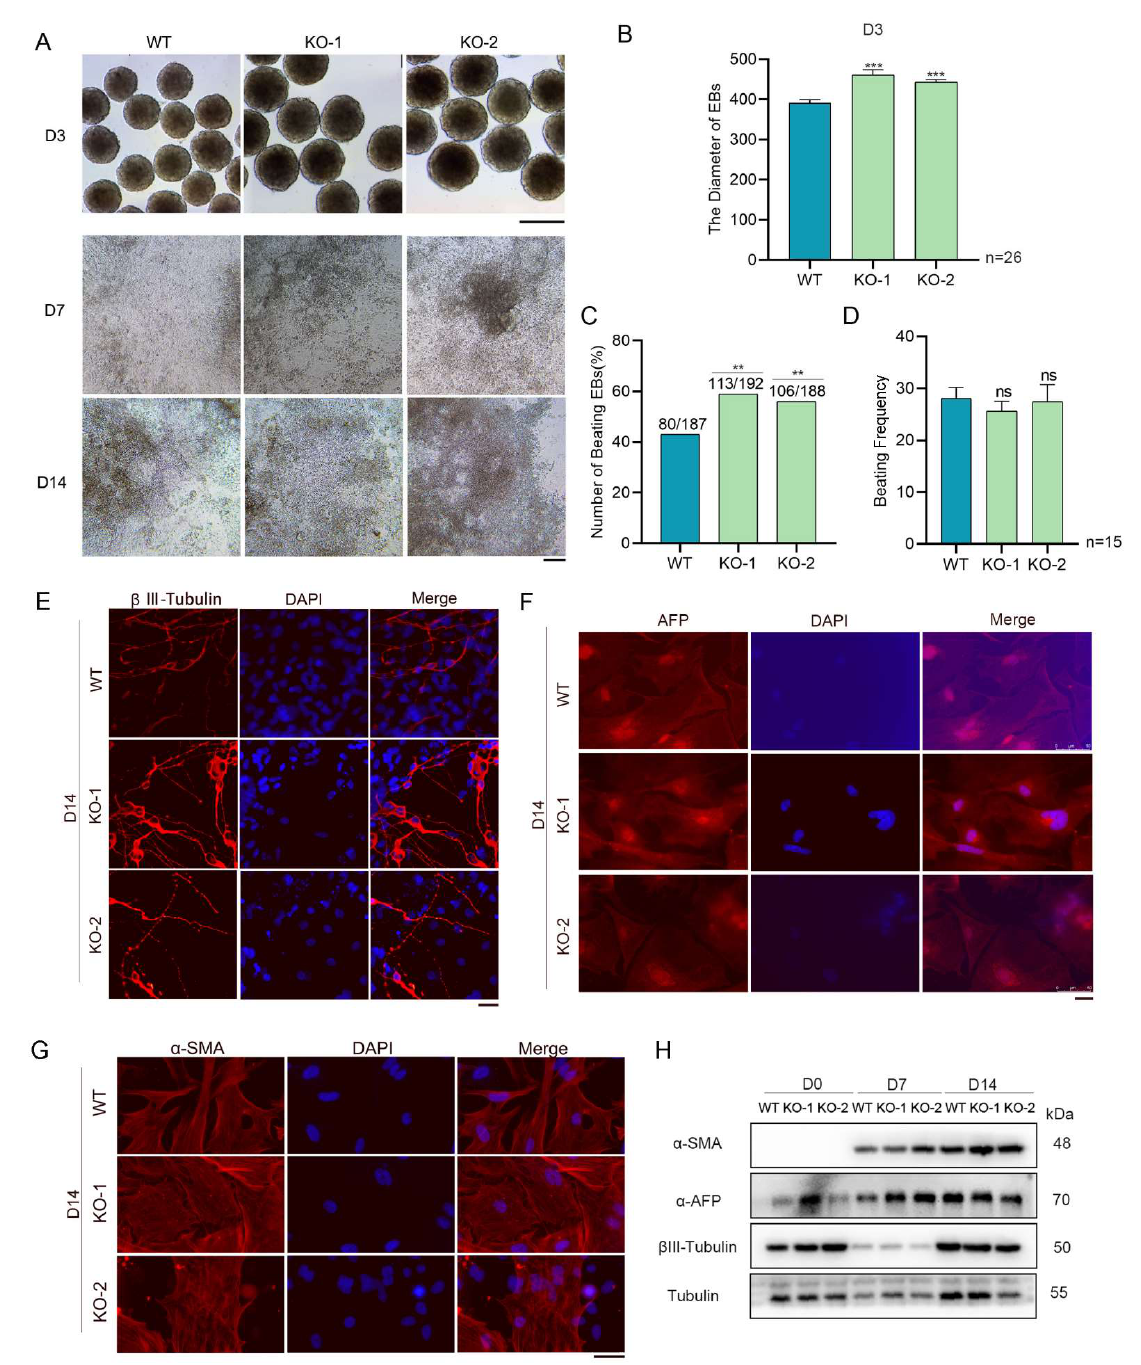
Figure 3. Snap29 depletion enhances the diameters of EBs and the incidence of beating EBs. ( A ) Morphology of embryoid bodies (EBs) at day 3 (scale bar, 400 µ m), and differentiated cells at day 7 and day 14 (scale bar, 50 µ m) derived from Snap29 +/+ and Snap29 − / − ESCs. ( B ) The diameters of day 3 EBs in ( A ). ( C ) Incidence of derivation of beating EBs in percentage (%). ( D ) Beating frequency of EBs (times per minute). ( E – G ) The differentiated derivatives of day 14 con- sist of cells representing three embryonic germ layers, as indicated by immunofluorescence staining of markers for ectoderm ( β III-Tubulin), endoderm (AFP), and mesoderm ( α -SMA). Scale bar = 25 µ m. ( H ) Western blot analysis of α -SMA, AFP, and β III-tubulin in the indicated cells. Mean ± SEM from three independent experiments. ** p < 0.01, *** p < 0.001, ns not significant ( p > 0.05), unpaired two-tailed Student’s t -test for ( B ) and ( D ), χ 2 test for ( C ), compared with WT